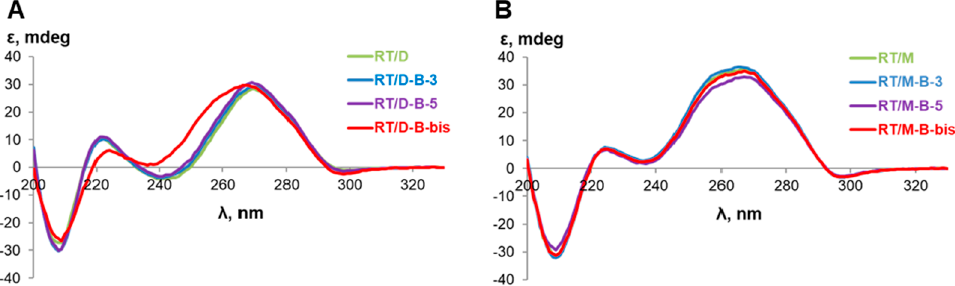
Figure 9. Circular dichroism (CD) spectroscopy curves of heteroduplexes formed by boron cluster-modified oligonucleotides with RNA-target ( RT ). ( A ) RNA/DNA duplexes; ( B ) RNA/2 ′ -O-Me-RNA duplexes. Conditions: 25 °C, 10 mM sodium phosphate (pH 7.5), 100 µM oligonucleotides.